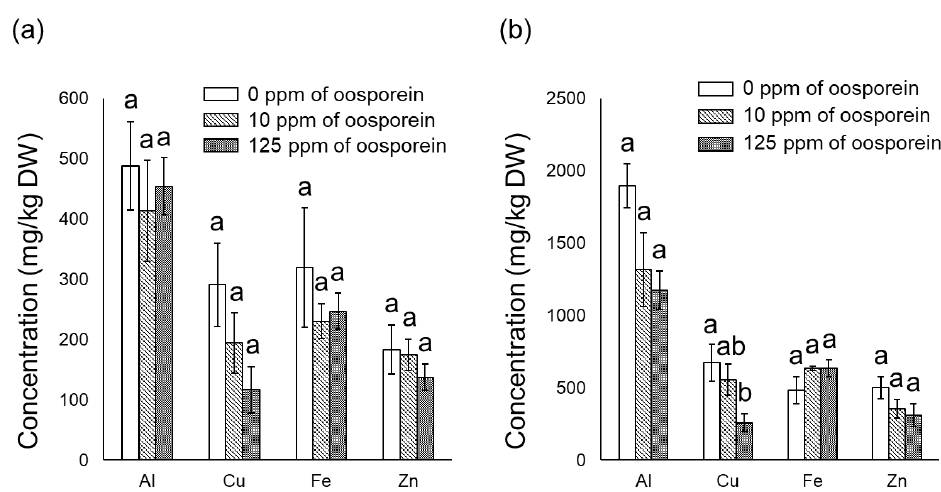
Figure 2. Al and heavy metal concentrations in Miscanthus sinensis seedlings after incubation in nutrient solution containing 100 µ M Al after oosporein treatment. ( a ) Concentration in aboveground parts, and ( b ) concentration in roots. After incubation of 3 h in 0, 10, or 125 ppm solutions of oosporein, the seedlings were transferred to 1/10 Hoagland solution containing 100 µ M Al and incubated for 30 days. Different letters (a and b) indicate a statistically significant difference among treatment in ANOVA comparisons and post hoc Tukey HSD at p < 0.05 ( n = 4). Error bars represent ±